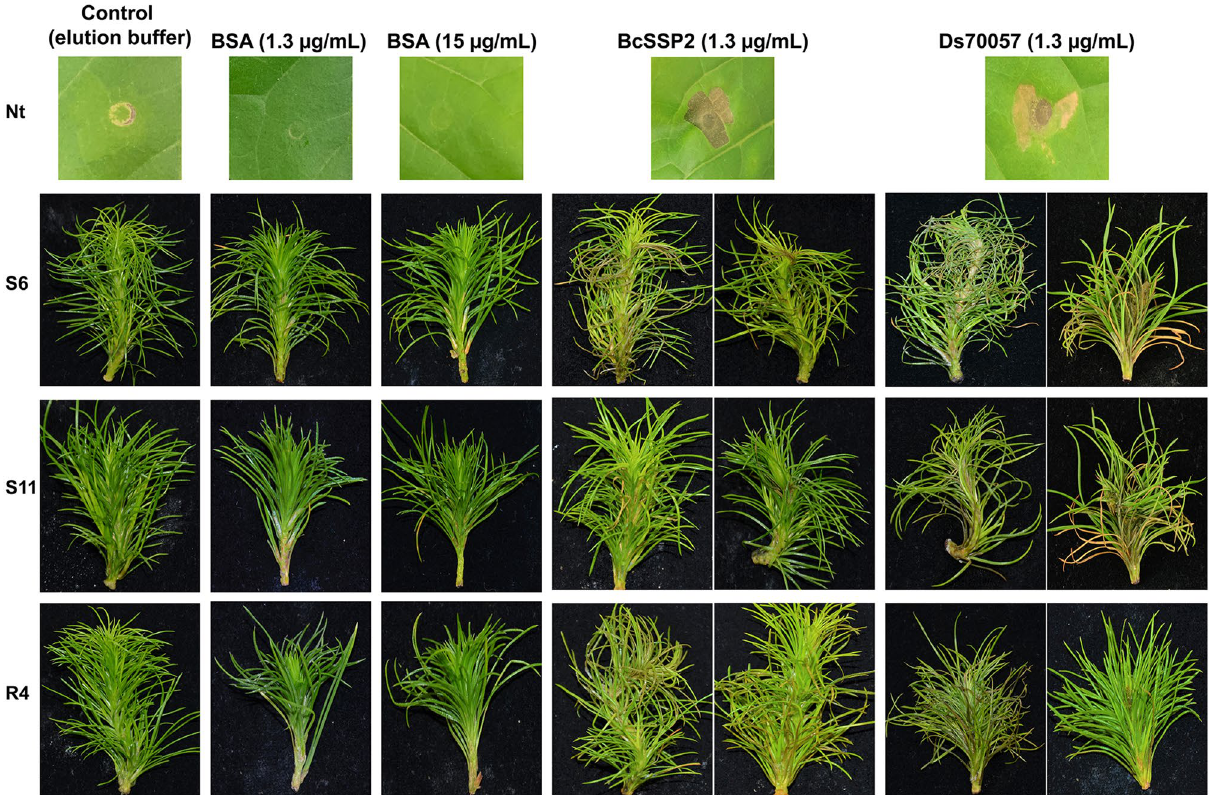
Figure 4. The Dothistroma septosporum candidate effector (DsCE) Ds70057 induces cell death in Pinus radiata shoots following vacuum infiltration. Whole shoots of P. radiata genotypes that are susceptible (S6 and S11) or tolerant (R4) to D. septosporum infection were infiltrated with purified Botrytis cinerea SSP2 (positive control) or DsCE Ds70057 protein produced by heterologous expression in Pichia pastoris . Negative controls were elution buffer only and solutions of bovine serum albumin (BSA). Representative photographs (from 18 to 24 pine shoots for each treatment) were taken 7 days after infiltration, with further images shown in Supplementary Fig. S4. The top panel shows infiltrations of the respective solutions into Nicotiana tabacum (Nt) for